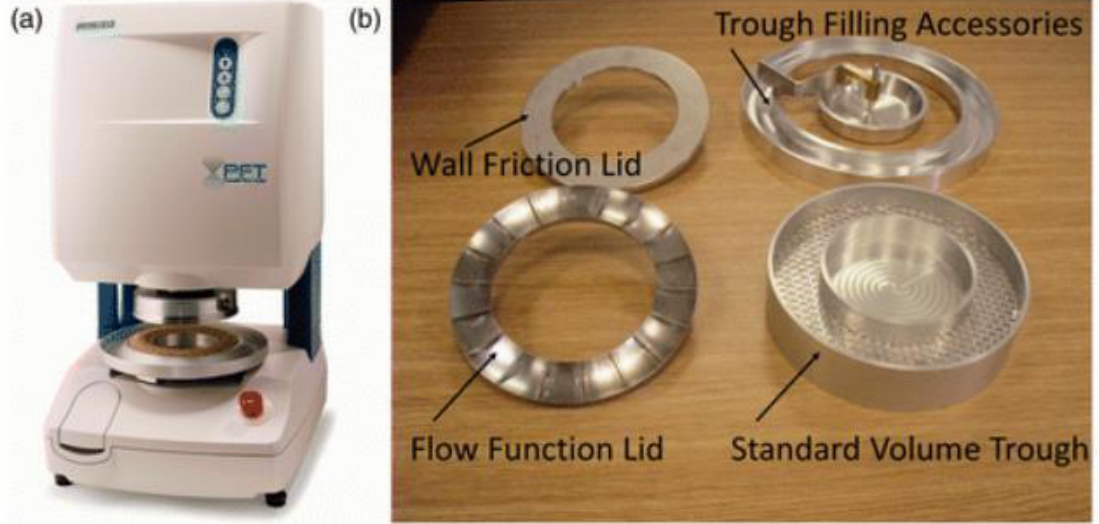
Figure 5. Brookfield PFT. ( a ) Instrument and ( b ) standard volume shear cell troughs, lid, and filling accessories (Berry et al., 2014).